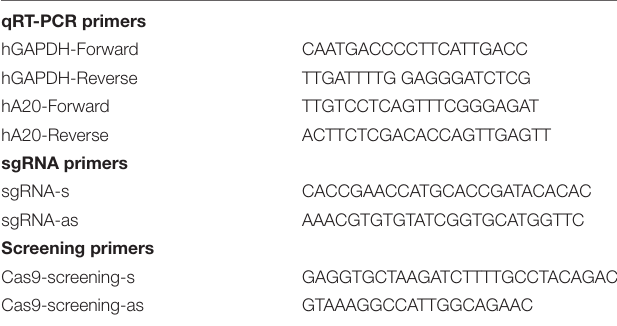
TABLE 1 | Sequences for primers used in the